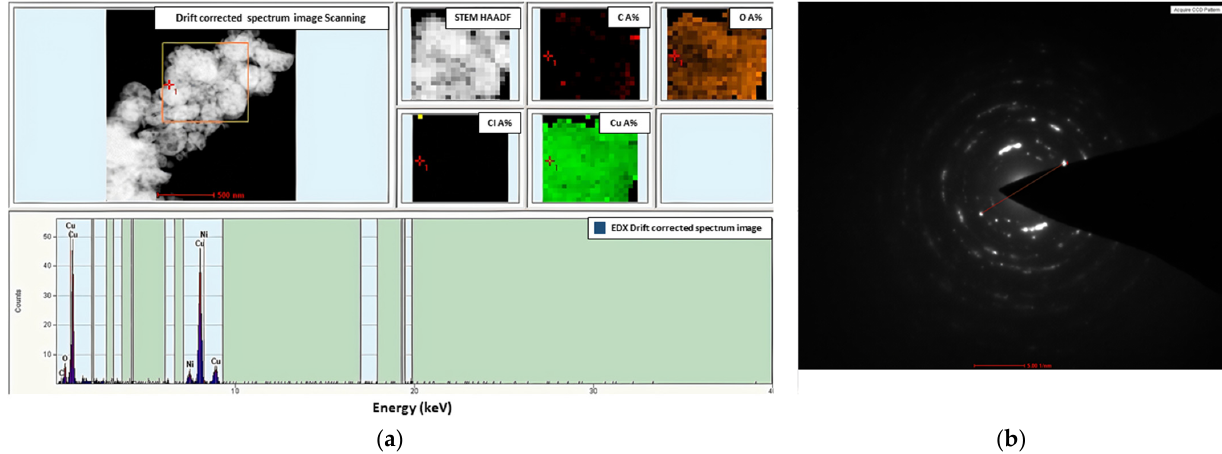
Figure 22. TEM data of the [Cu 2 (EtNH 2 ) 2 (µ-O 2 CC 3 F 7 ) 4 ] ( 3 )/Si after heating, ( a ) TEM image (top left), chemical mapping (top right) and EDX spectrum (bottom), ( b ) diffraction pattern d h k l = 2/5 nm = 0.4 nm.